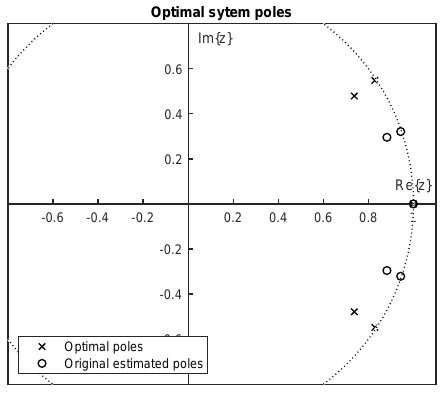
Figure 2. Optimal poles obtained with optimal sampling time and original estimated poles from simulated